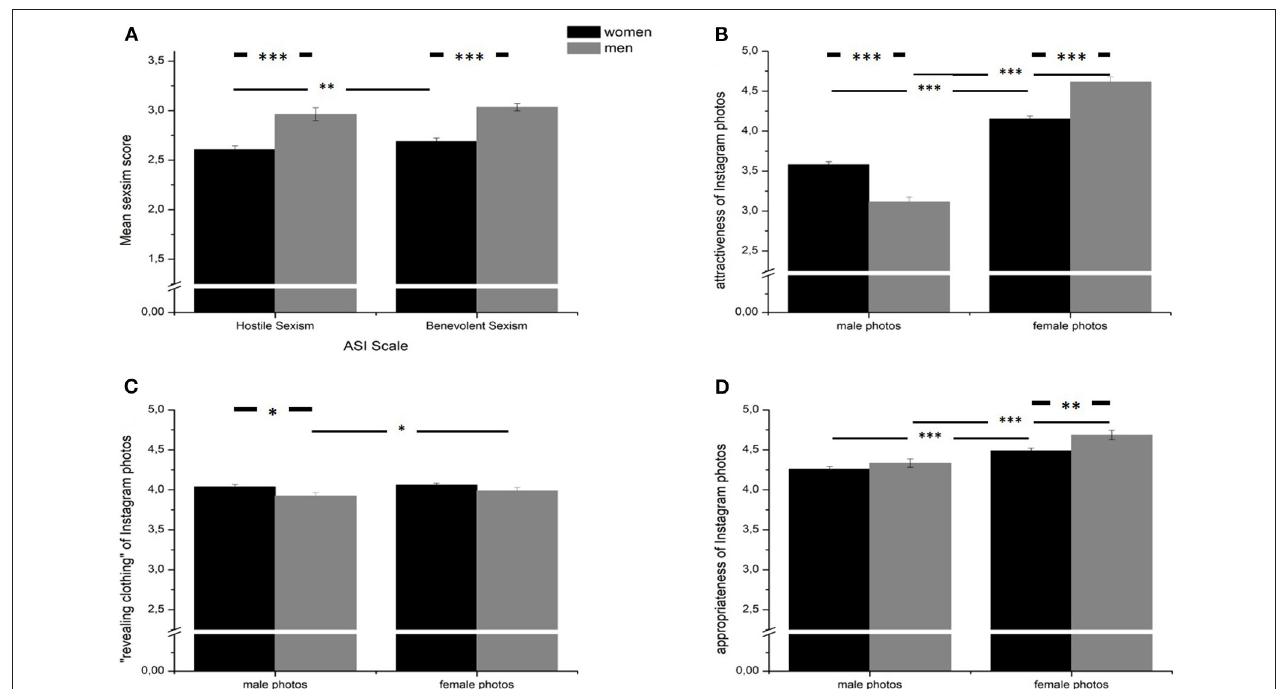
FIGURE 1 | Mean differences between women (black) and men (gray) in (A) hostile and benevolent sexism and the three rating dimensions (B) attractiveness, (C) revealingness, and (D) appropriateness of the presented Instagram photos. * p < 0.05, ** p < 0.01, *** p < 0.001.